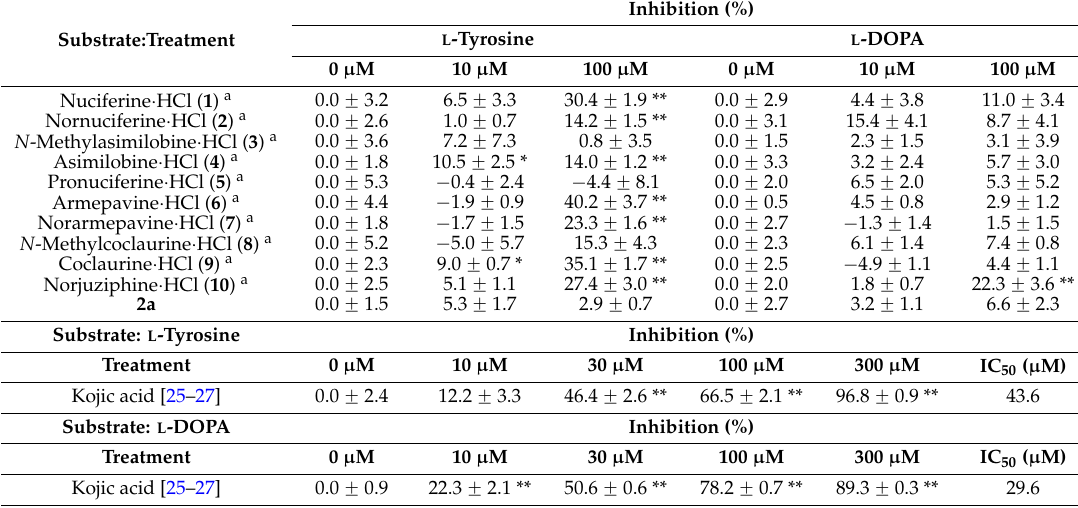
Table 8. Effects on activity of tyrosinase from mushroom.